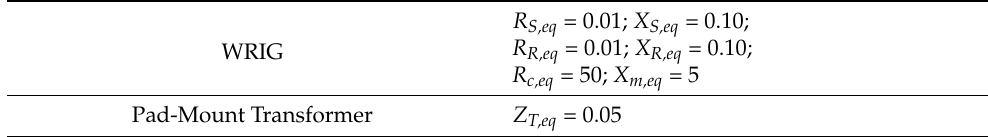
Table 6. Parameter of WPP single machine representation.